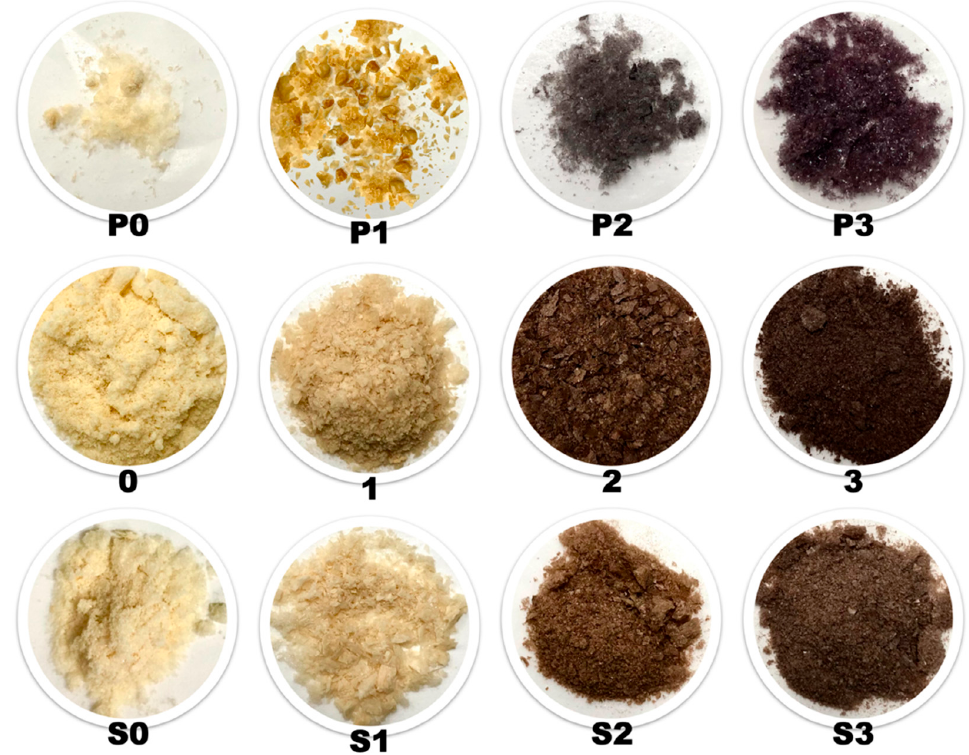
Figure 4. AQ powder after lyophilization: Top (left to right): presoaking water samples (P0–P3); middle: w/o presoaking AQ samples (0–3); and bottom: w/presoaking AQ samples (S0–S3). Glycitin (C 22 H 22 O 10 ), an isoflavone beta-glucoside with antioxidant effects, is